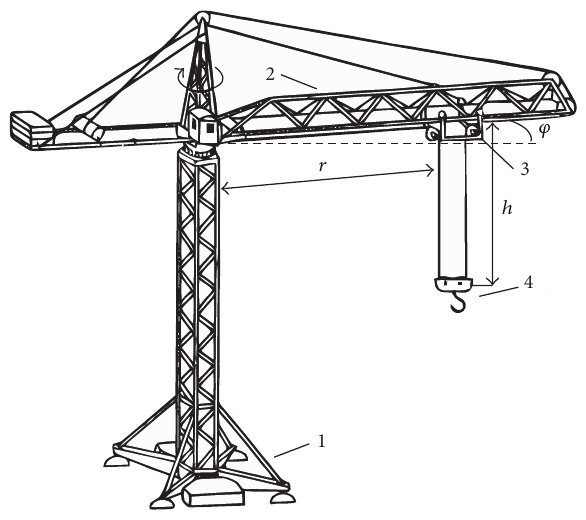
Figure 1: Mechanism